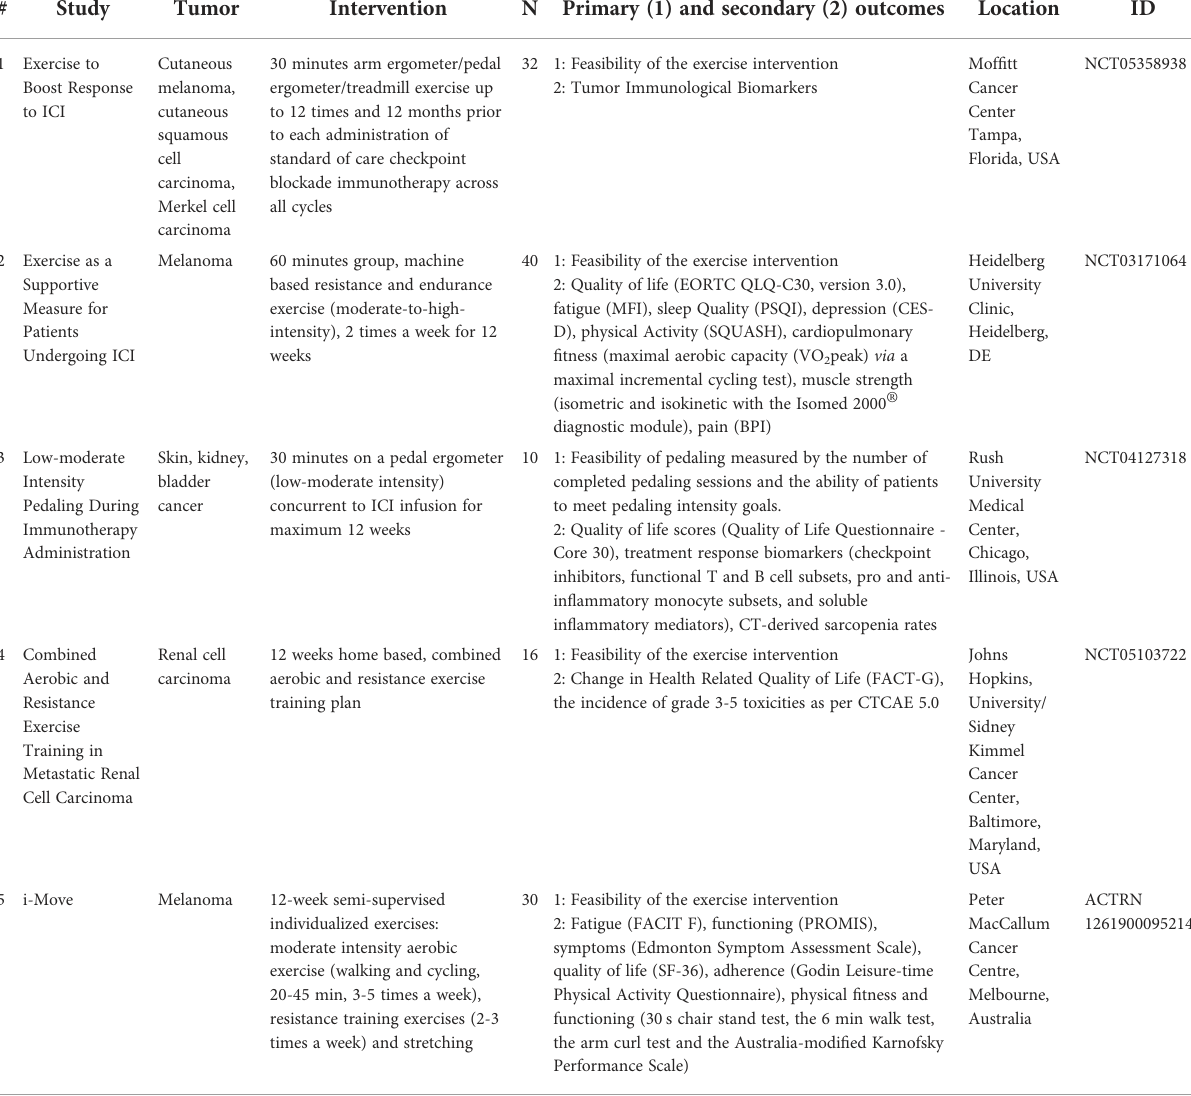
TABLE 1 Ongoing studies researching behavioral factors and immune checkpoint inhibition